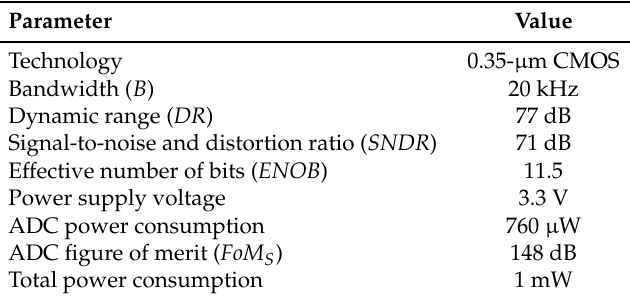
Table 2. Measured performance summary (example